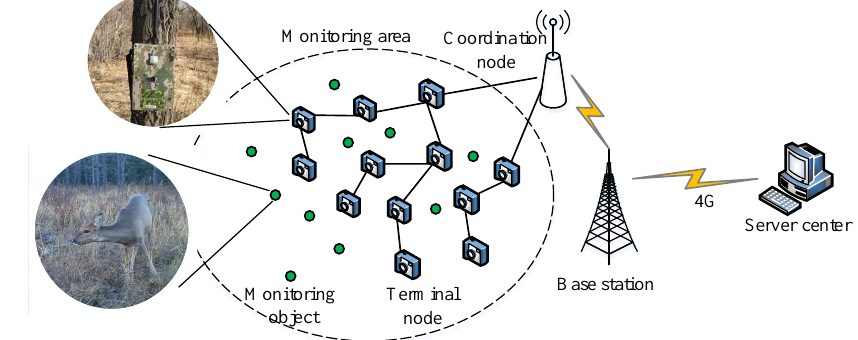
Figure 1. Wildlife monitoring system.